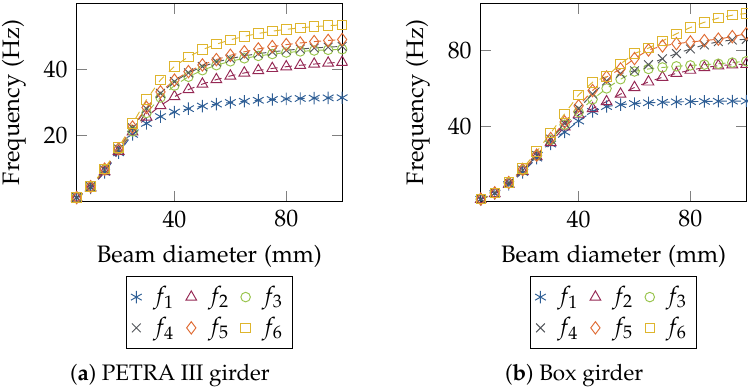
Figure 17. First six eigenfrequencies depending on the cross section diameter of the beams connecting the magnets to the PETRA III girder ( a ) and the box girder ( b ).